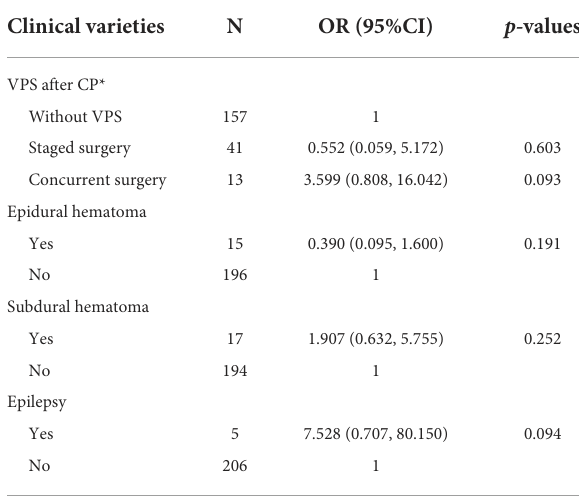
TABLE 6 Multivariate logistics regression analysis on post-discharge overall